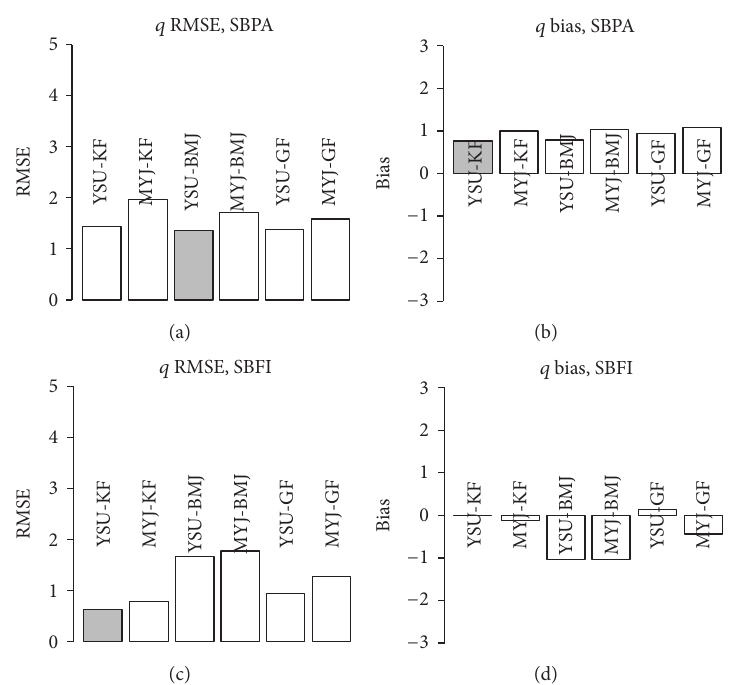
Figure 9: As in Figure 8 but for the simulated profiles of water vapor mixing ratio at SBPA [(a)-(b)] and SBFI [(c)-(d)] sites.